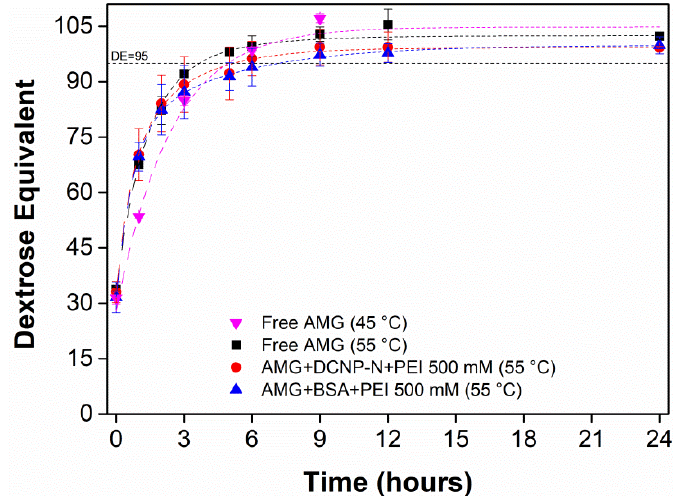
Figure 15. Profile of hydrolysis of 35% ( w / v ) starch (pre-hydrolyzed with α -amylase) catalyzed by free amyloglucosidase (AMG) and AMG CLEAs prepared by enzyme treatment with polyethyleneimine (PEI) and by co-aggregation with the magnetic nanoparticles DCNP-N or bovine serum albumin (BSA) at 45 and 55 °C and pH 4.5 under 900 rpm stirring. Amount of AMG: 2 mL of free enzyme/kg of starch (37,820 U/kg of starch) or equivalent units to the CLEAs. The reaction conversion (starch-to-glucose) was monitored by Dextrose Equivalent (DE) measuring reducing sugars by DNS method. Values are shown as the mean of duplicate experiments ± s.d.